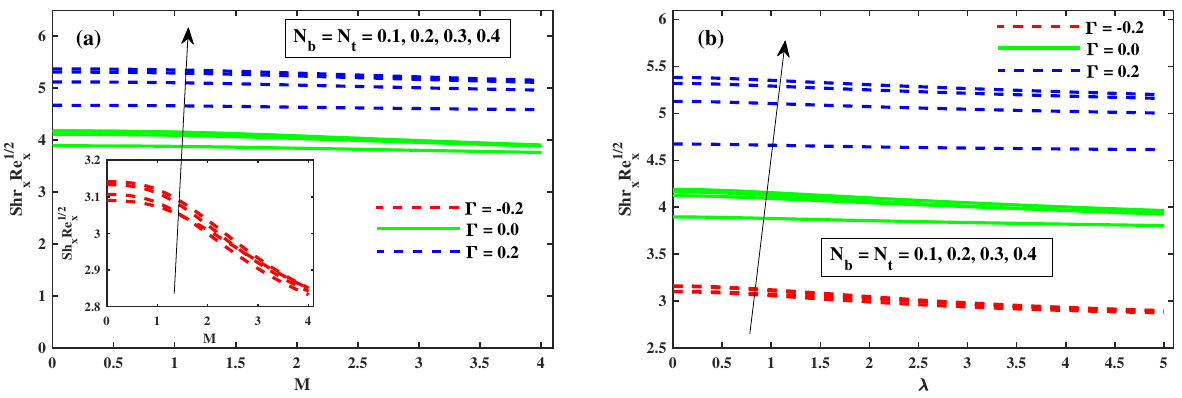
Figure 14. The effect of N b , N t for M in ( a ) and for λ in ( b ) on Sherwood number.